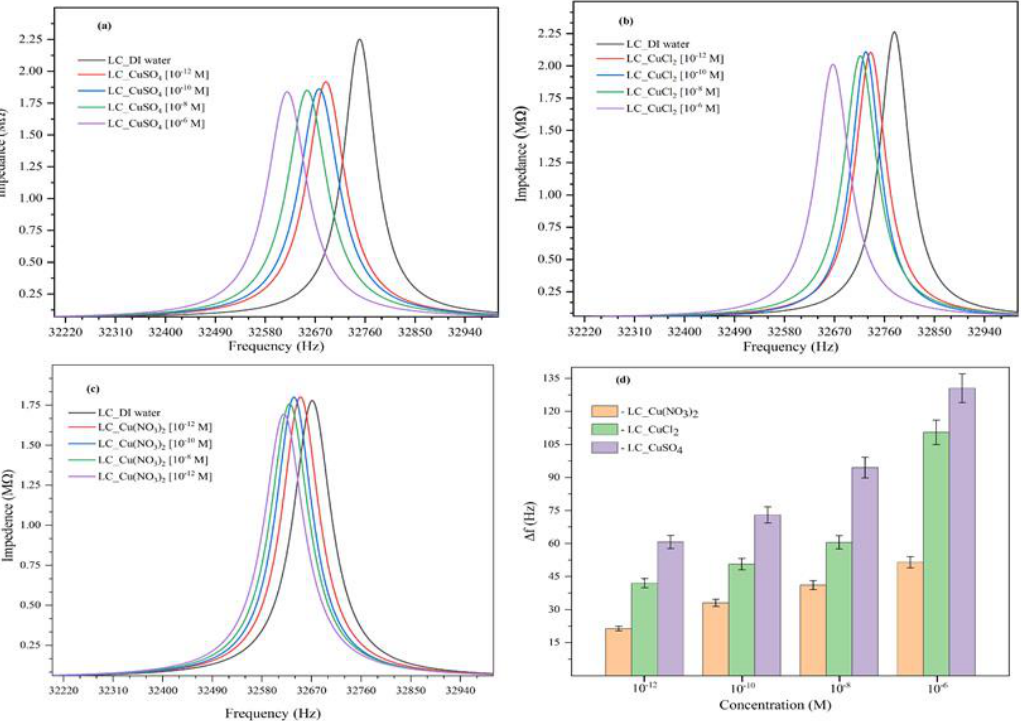
Figure 3. Comparison of the resonance frequency responses of the Au-coated QTFs functionalized with LC with the different concentrations (10 − 12 M to 10 − 6 M) of each of the aqueous Cu 2+ salt solutions: ( a ) CuSO 4 , ( b ) CuCl 2 , ( c ) Cu(NO 3 ) 2 , and ( d ) summary histogram showing the relative resonance frequency shifts ( ∆ f) +/ − ~5% to the three copper salts tested. Table 1. Comparison of the resonance frequency shift of the LC functionalized Au-coated QTFs in the different analyte concentrations (10 − 12 to 10 − 6 M) of the three analytes. Resonance Frequency Shift Analyte Concentration (M)